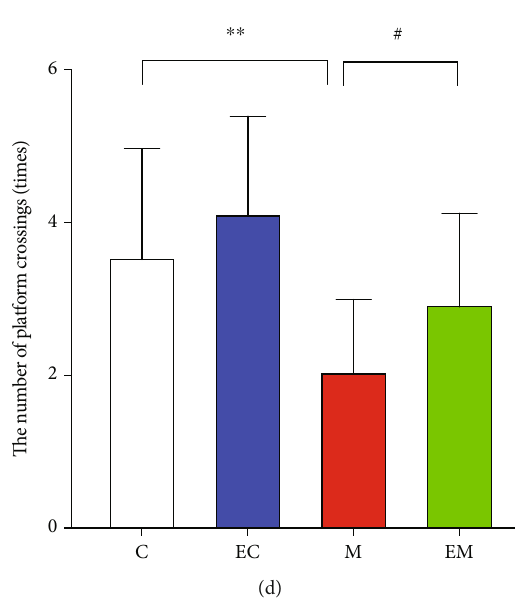
Figure 1: (a) Morris water maze swimming path for each group of mice. (b) Evasion latency time of mice. (c) Evasion latency time of mice. (d) Number of times that mice crossed the platform. ∗ P < 0 : 05 and ∗∗ P < 0 : 01 vs. group C; # P < 0 : 05 and ## P < 0 : 01 vs. group M.